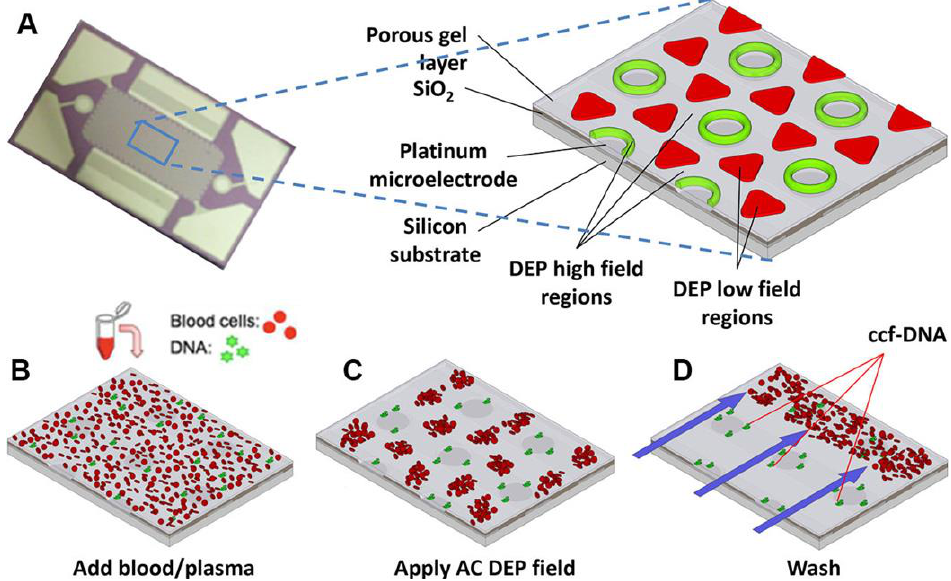
Figure 7. DEP microarray device and scheme for isolation of ccf-DNA from blood and plasma. ( A ) Upper image shows the alternating current electrokinetic microarray device (chip) used to carry out the isolation of ccf-DNA directly from blood. Expanded view shows the device materials composition: porous gel, platinum microelectrodes, SiO 2 layer, and silicon base; and the location of the DEP high-field (green) and the DEP low-field (red) regions when an AC field is applied. Lower figure shows ( B ) microarray with whole blood (red circles) containing fluorescent DNA (green dots); ( C ) application of the AC electric field causing the fluorescent DNA (green dots) to be concentrated in the DEP high-field regions on the microelectrodes, while the blood cells (red circles) move into the DEP low-field regions between the microelectrodes; and ( D ) the AC field remains on while a fluidic wash removes the blood cells from the microarray with DNA remaining concentrated in the DEP high-field regions. Reproduced with permission [107] 2014, Wiley.